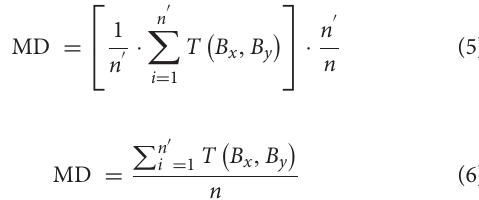
based on the TFCE- and RNN-reconstructed maps (MD TFCE and MD RNN ,